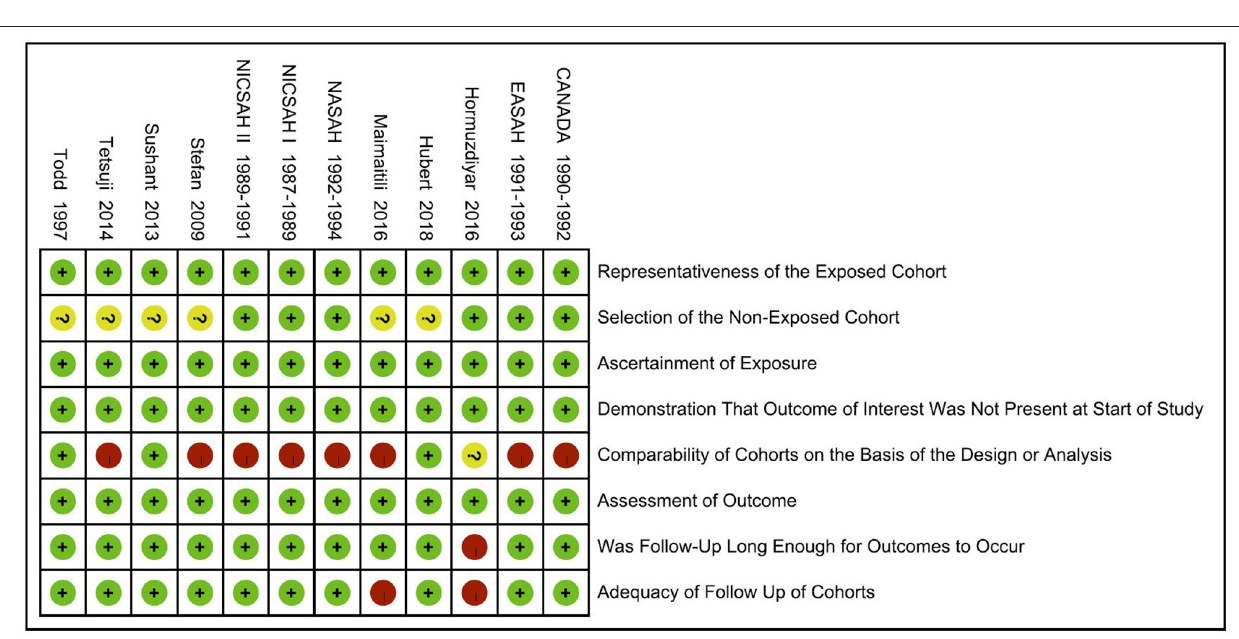
FIGURE 8 | Risk-of-bias summary: review authors’ judgements about each risk-of-bias item for each included